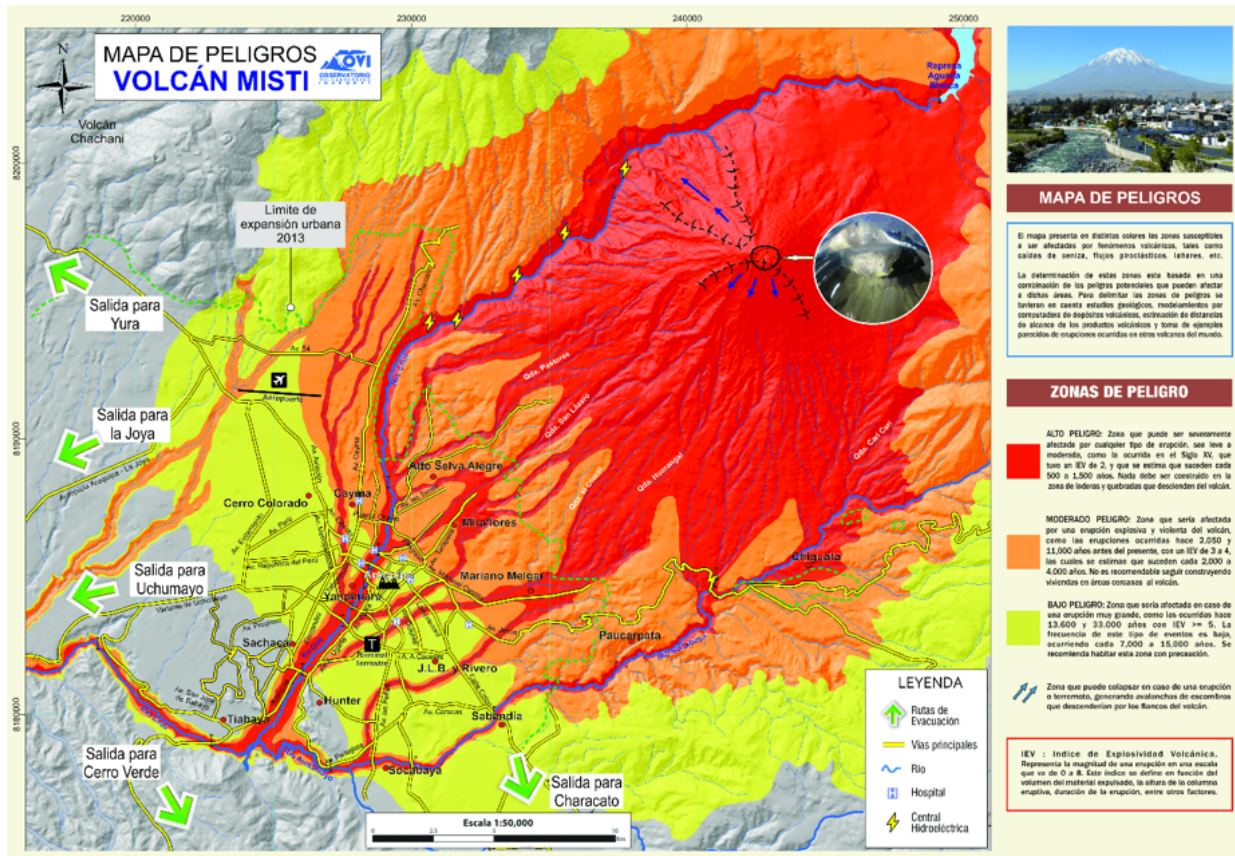
Figure 1: Multi-hazard map of the proximal zone of Misti